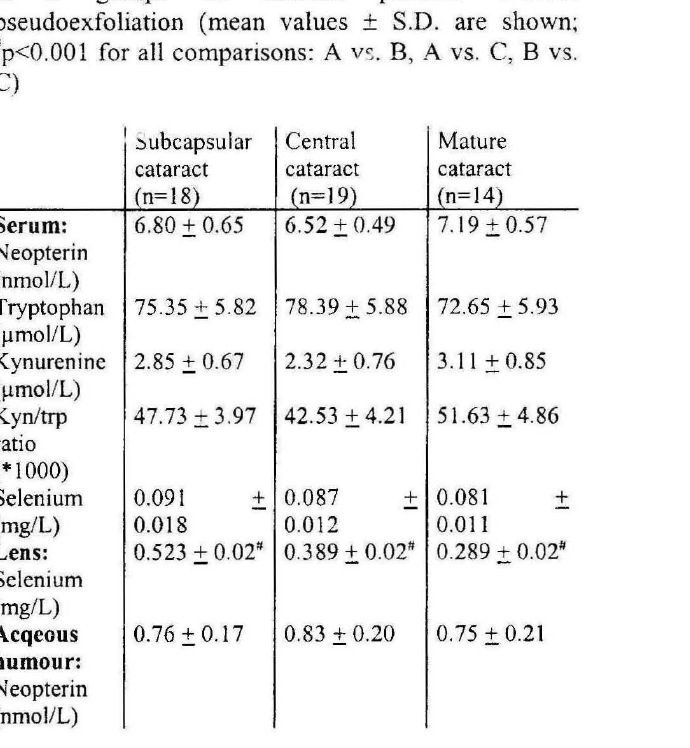
Table 1. Serum neopterin, tryptophan,